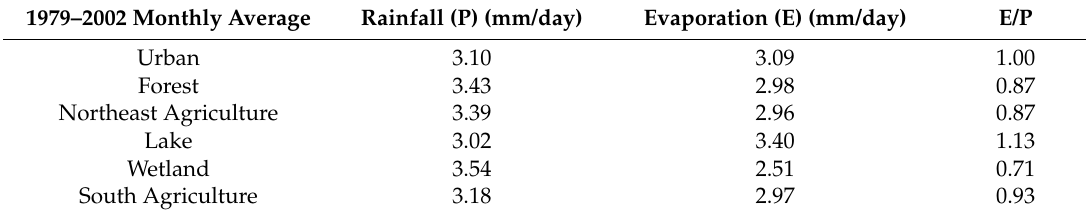
Table 1. Annual Mean (1979–2002) Rainfall and Evaporation for the Various Land Uses in Florida.